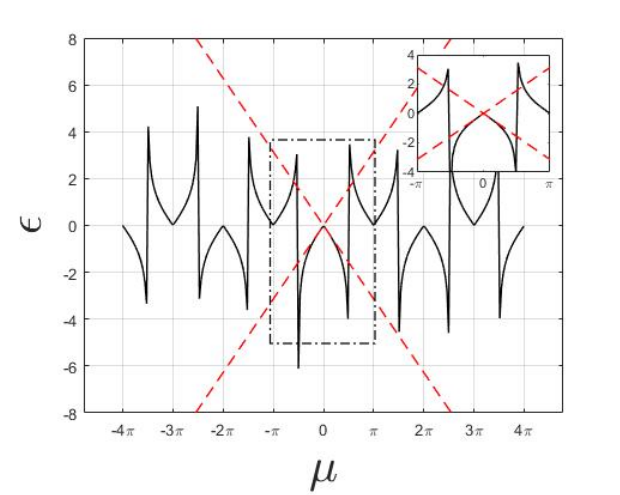
And and ε µ − ε = 0